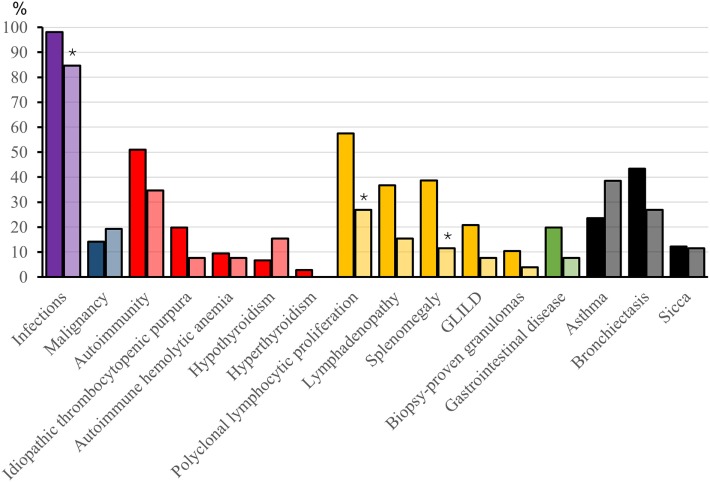
Complications (%) in probable and possible CVID patients. Asterisks mark statistical significance between “probable” and “possible CVID” patients, *p < 0.05 (Fisher’s 2-sided Exact test or Pearson Chi-square, as appropriate). For each complication, data are presented with pairwise bars for “probable” and “possible CVID” where “probable CVID” is first and with darker color. Sicca diagnosis was based on doctor-assessed symptoms and findings.